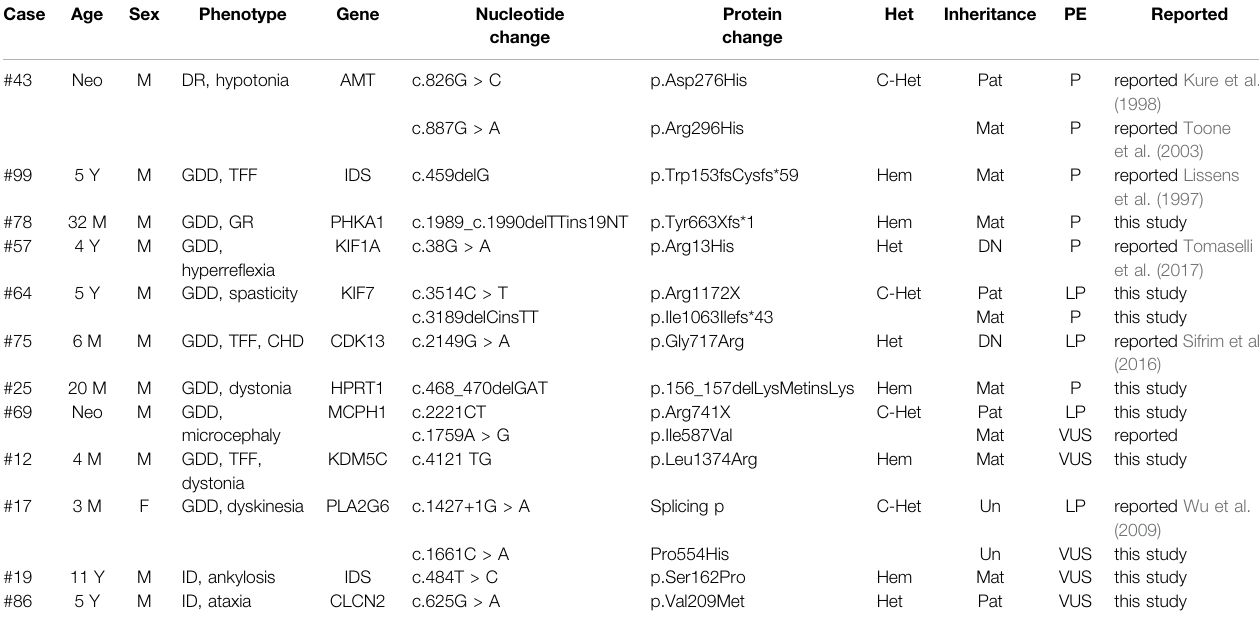
TABLE 3 | SNVs identi fi ed by WES in 12 patients with ID.